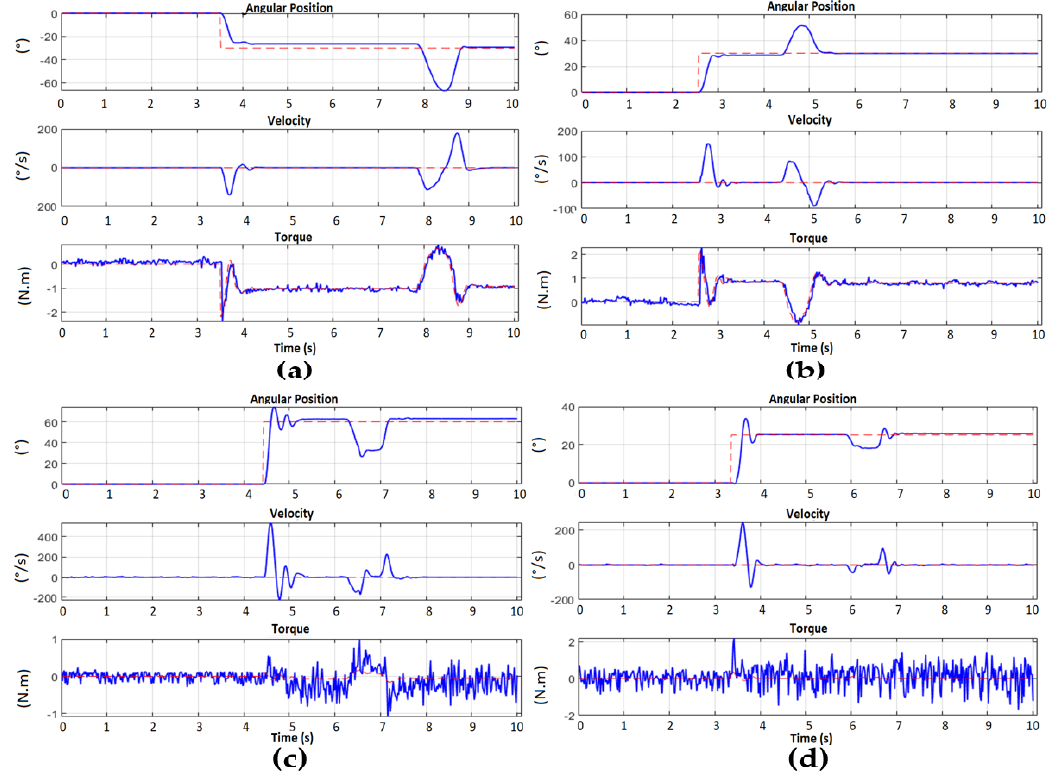
Figure 22. Left arm position regulation with subsequent disturbance. ( a ) Motor 1 from 0 ◦ to − 30 ◦ ; ( b ) Motor 2 from 0 ◦ to 30 ◦ ; ( c ) Motor 3 from 0 ◦ to 60 ◦ ; ( d ) Motor 4 from 0 ◦ to 30 ◦